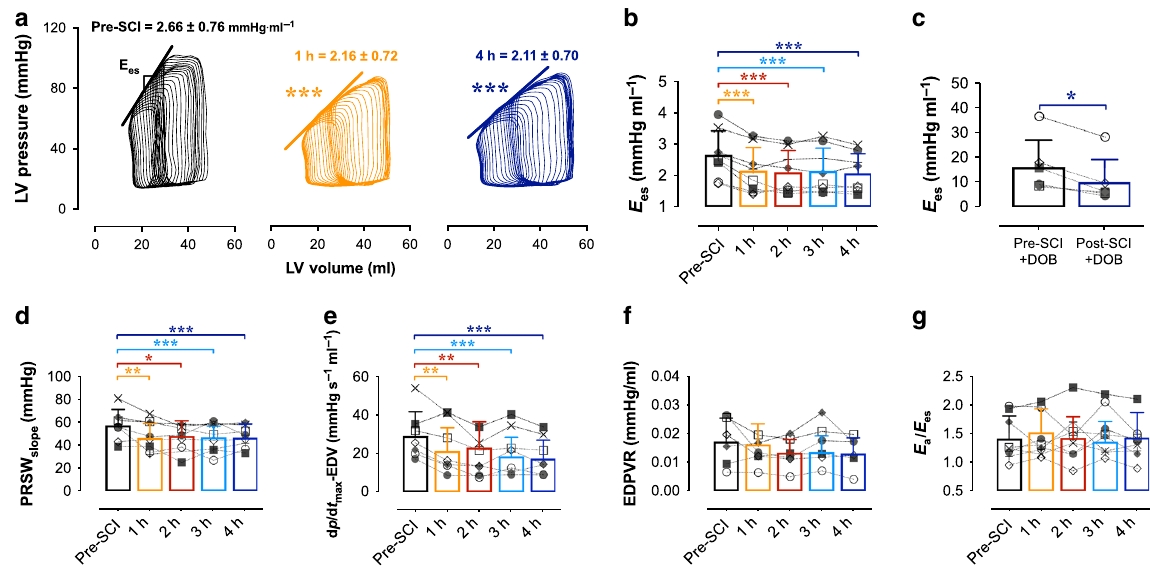
Fig. 2 Impaired LV systolic load-independent function in acute T2 SCI. a Representative PV loops during IVC occlusions illustrate impaired LV contractility (end-systolic elastance; E es ) within 1 h (middle, orange; p < 0.001) and up to 4 h (right, blue; p < 0.001) post-SCI. b Bar plots and error bars represent means and s.d., and symbols represent individual animal data. Group data show the reduction to E es acutely post-SCI. c Animals additionally had reduced E es responses to dobutamine challenges ( ‘ DOB ’ , 10 μ g kg − 1 min − 1 ) post-SCI ( p = 0.025). d Impaired systolic load-independent function is further supported by the early (1 h; p = 0.0047) and sustained reductions to preload-recruitable stroke work (PRSW; p < 0.001 at 4 h vs pre-SCI) and e the rate of maximal pressure generation for a given EDV (dp/dt max − EDV; p < 0.001 at 4 h). f The end-diastolic pressure – volume relationship (EDPVR) was not altered acutely post-SCI. g There were no changes to the relationship of arterial elastance (E a ) to E es , due to simultaneous reductions in LV afterload and contractility following SCI. * p < 0.05, ** p < 0.01, *** p < 0.001 versus pre-SCI. See Fig. 1 for statistical analyses, and Supplementary Table 2 for detailed statistics. Source data are provided as a Source Data fi